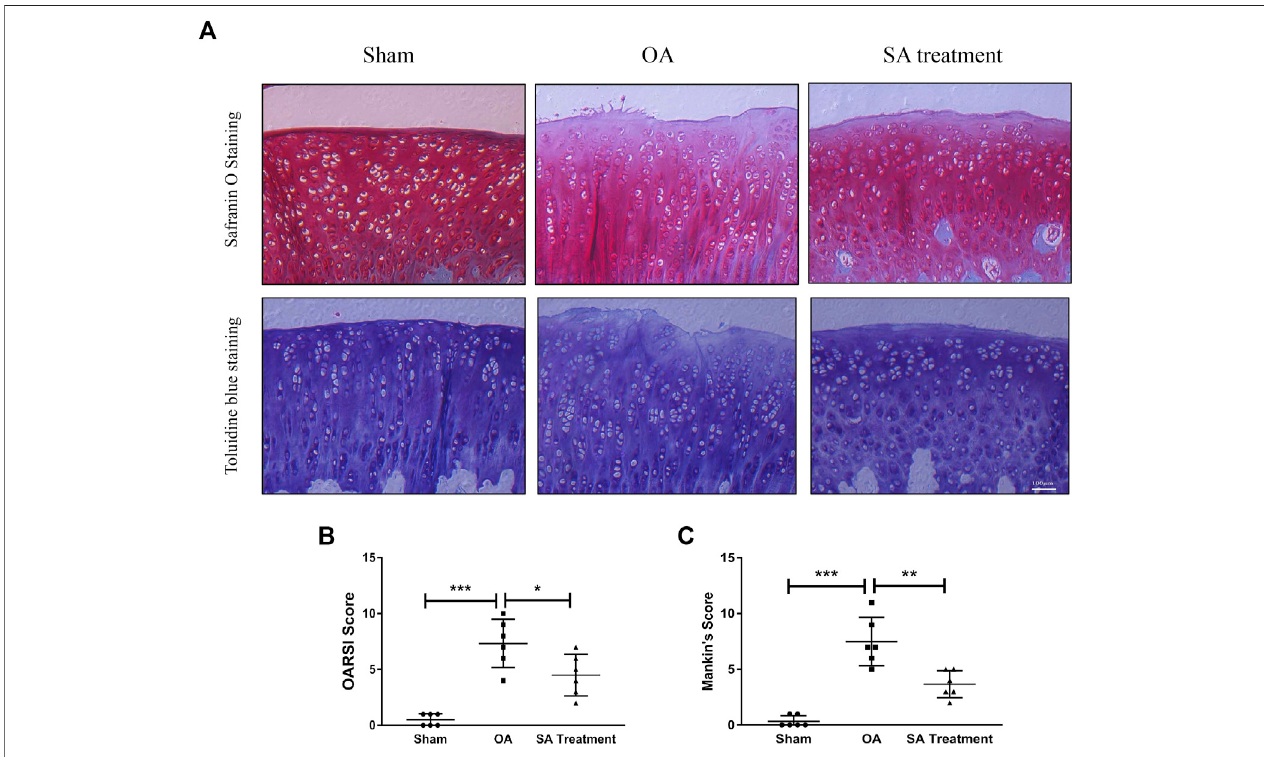
FIGURE8| SAmitigatescartilagedegradationinaratOAmodel invivo . (A) Microscopicphotosofsafranin-O/fastgreen-andtoluidineblue-stainedsectionsofrat kneejointsfromthethreegroups. (B) OARSIscoresofeachgroup.Thedataareshownasthemean ± SD( n (cid:2) 6).Signi fi cantdifferencesbetweengroupsareindicatedas *** p < 0.001; p p <